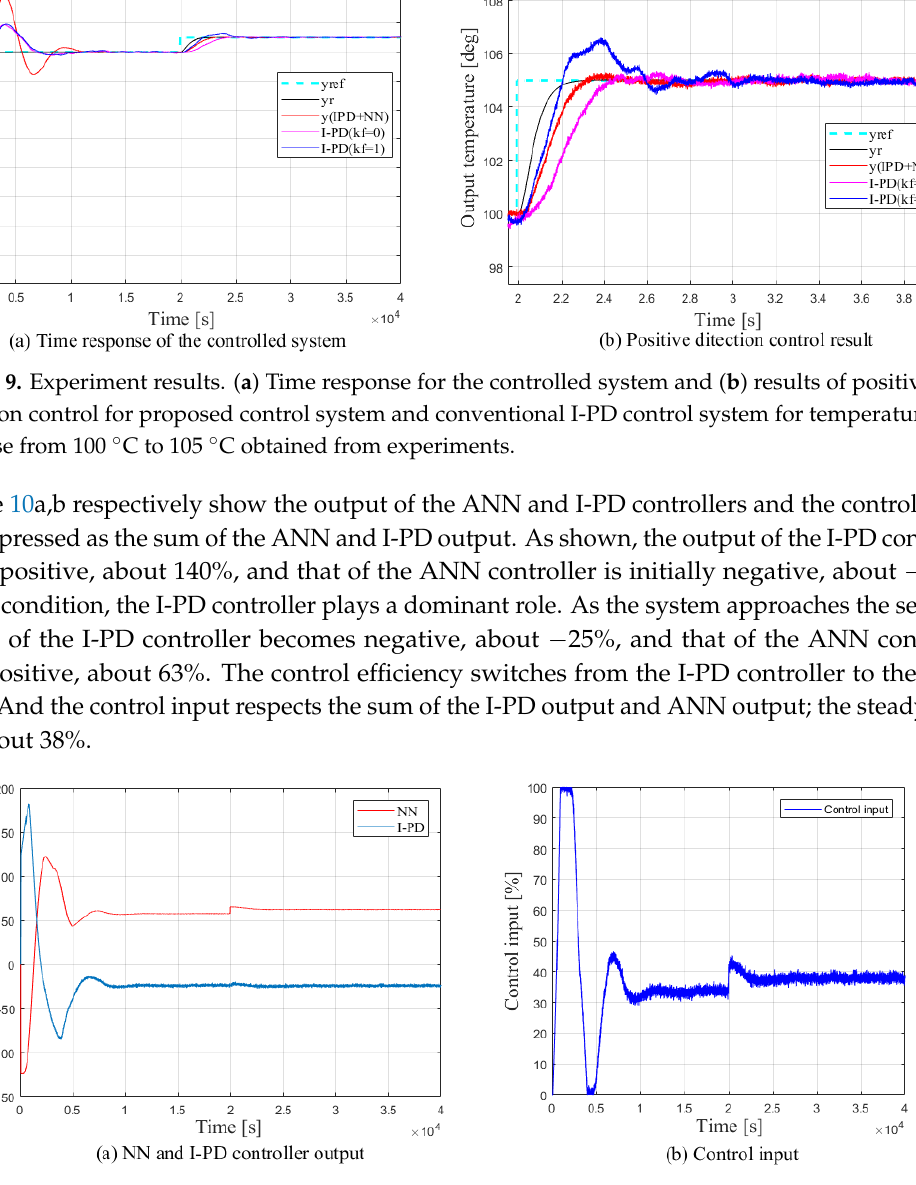
Figure 10. ( a ) Outputs of ANN controller and I-PD controller and ( b ) control input obtained from